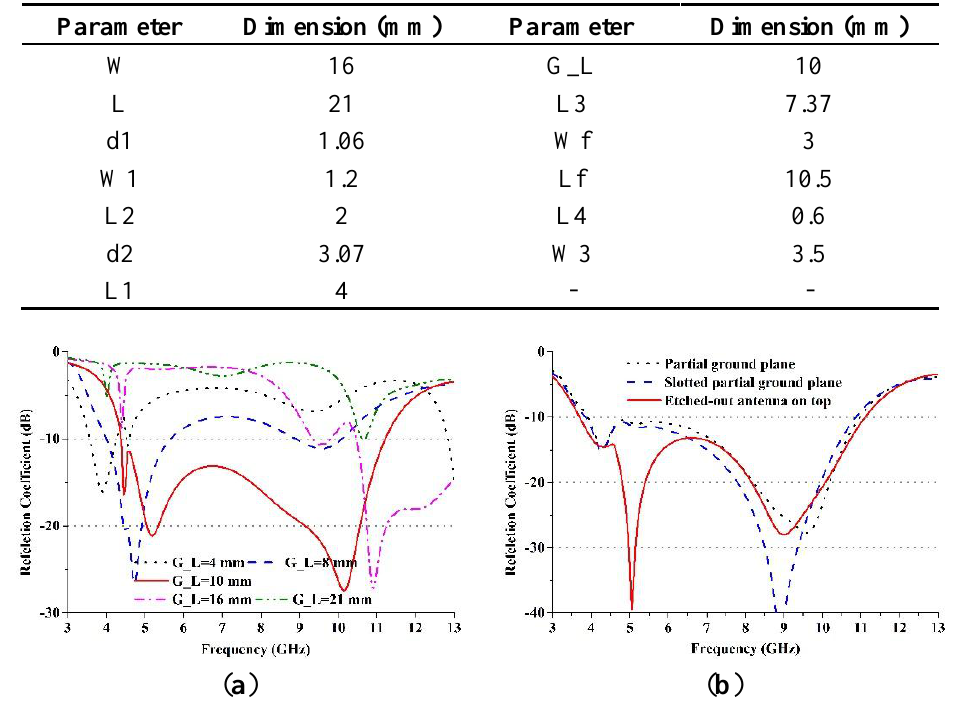
Figure 6. Proposed antenna ( a ) geometry layout ( b ) bottom view ( c ) Cross sectional view. Table 3. Antenna design specifications (according to Figure 6).